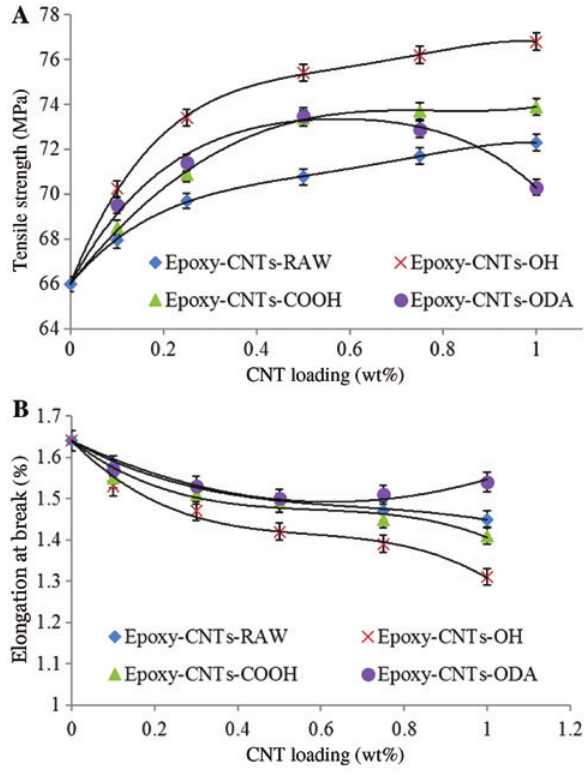
Figure 6: Tensile properties of pure epoxy and epoxy- nanocomposites at different CNT loading. (A) Tensile strength; (B) Elongation at break